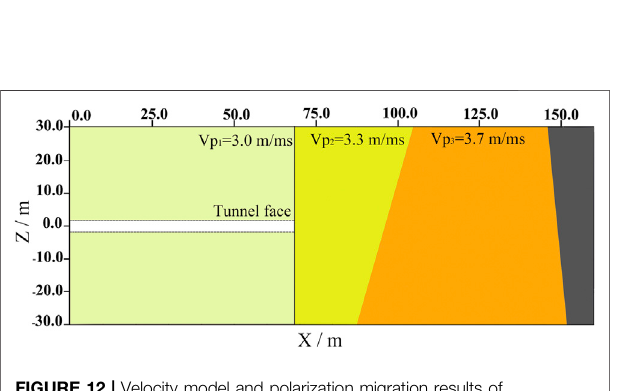
FIGURE 12 | Velocity model and polarization migration results of PMVMB method. Since there are only two layers of re fl ected signals in Figure 11 , theseismic wavevelocity in therightmost areain this fi gure cannot be determined.